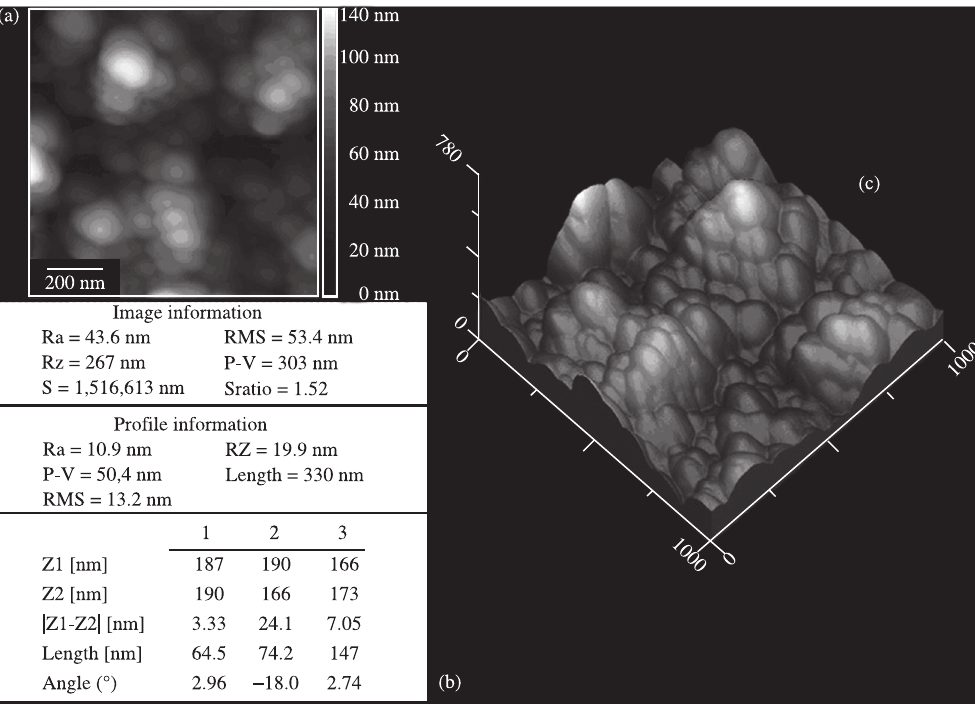
Figure 2. Atomic force microscopy images of the semi-spherical morphology of the surface topography of zinc aluminate ceramic film (a). Analysis measure- ment of the semi-spherical morphology of zinc aluminate ceramic films (b). A three-dimensional image features of the surface topography of zinc aluminate ceramic film (c).